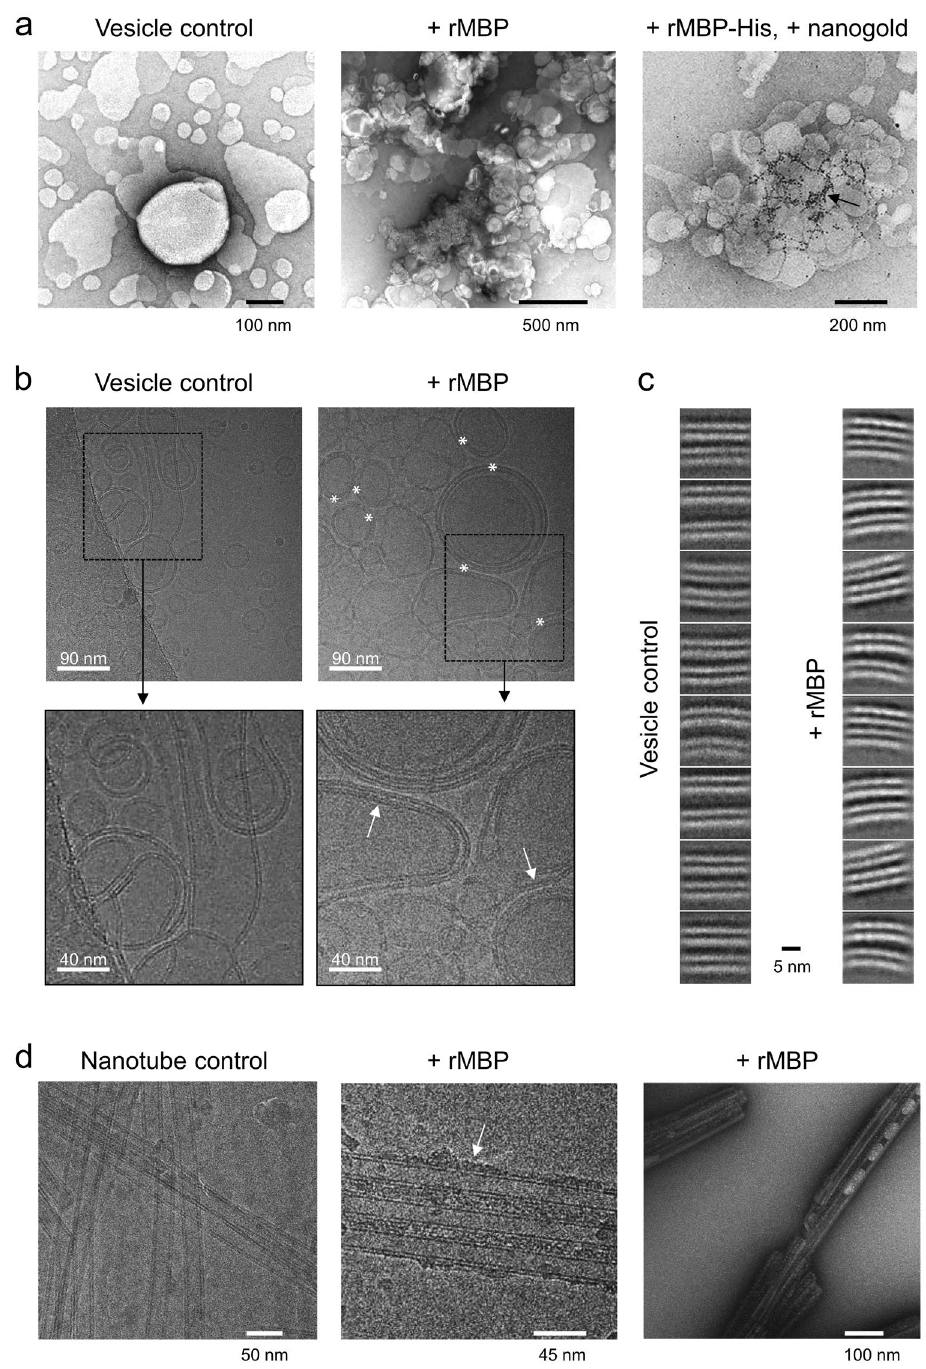
Figure 4. Architecture of rMBP in membrane stacks. ( a ) MBP aggregates vesicles and settles between membranes. rMBP-His was labelled with nanogold particles to localise the protein between vesicles (black arrow). ( b ) In cryo-EM, membrane stacking by MBP is evident when mixed with lipid vesicles (white asterisks). MBP also slightly flattens the membrane curvature of vesicles when more than one stack builds up (white arrows). ( c ) Particle analysis of cryo-EM imaged vesicles unveils an intermembrane compartment occupied by a uniform rMBP phase devoid of clear single particle boundaries, which brings the two apposing membranes into close vicinity to each other. The space between adjacent vesicle bilayers in the absence of rMBP is notably wider. ( d ) MBP coats GalCer-DOGS-NTA-Ni 2 + nanotubes, displaying an extended conformation (white arrow). MBP also aggregates nanotubes, as evident from negatively stained samples